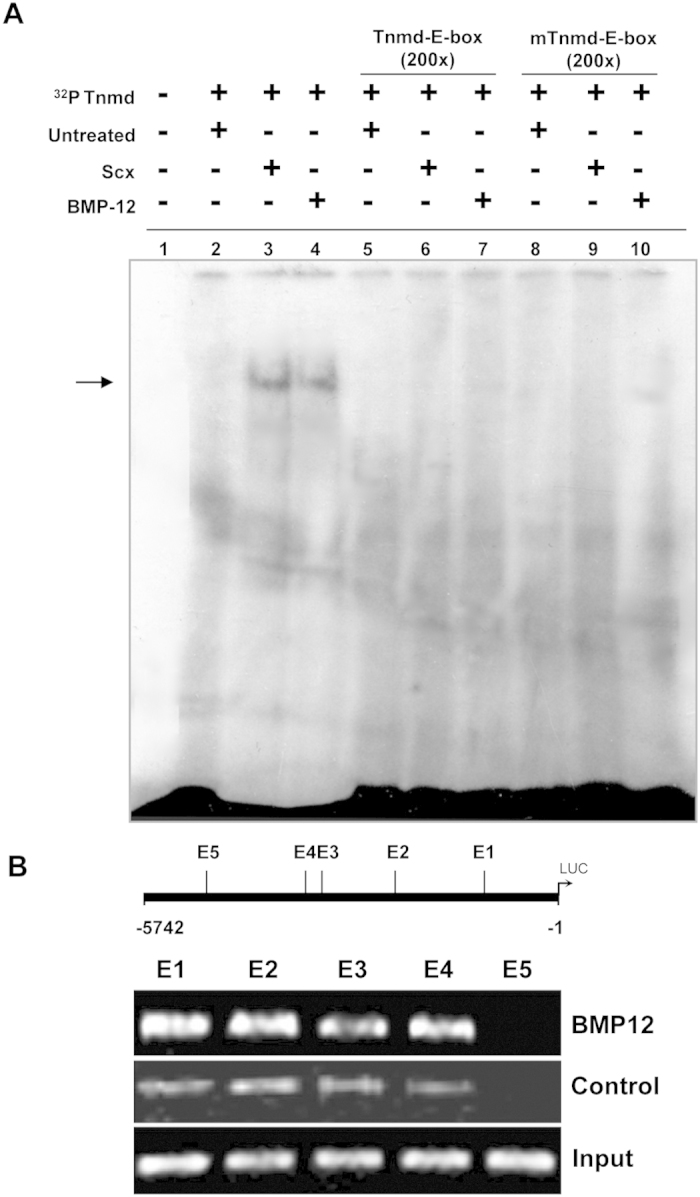
Transactivation of tenomodulin by scleraxis in C3H10T1/2 cells.(A) Binding of Scx to Tnmd E-boxes assessed by electrophoretic mobility shift assays (EMSA) Olgionucleotide probes corresponding to a specific E-box consensus sequence were incubated with nuclear extracts from C3H10T1/2 cells with either Scx overexpression and/or BMP-12 treatment or left untreated (control). (B) Binding of Scx to Tnmd E-boxes assessed by chromatin immunoprecipitation (ChIP) assays. Cross-linked chromatins were prepared by immuneprecipitated cellular lysates using anti-scleraxis antibodies and purified DNA was used to PCR amplify the biding regions of Tnmd promoter. The binding of Scx to all tested Tnmd E-boxes except 5 was detected in BMP-12-treated cells. Upper panel, distribution and localization of E-boxes in Tnmd promoter.